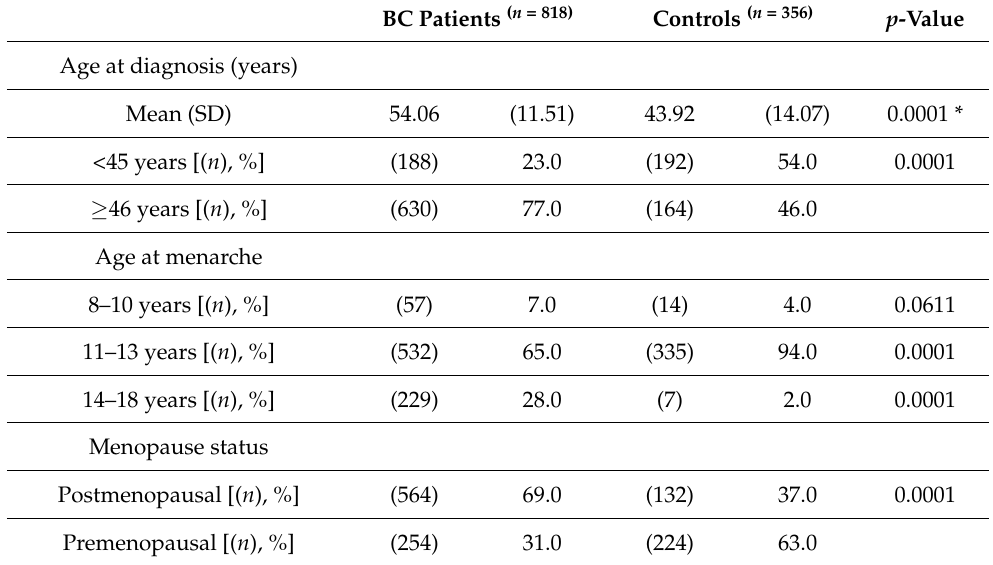
Table 1. Demographic data for the study